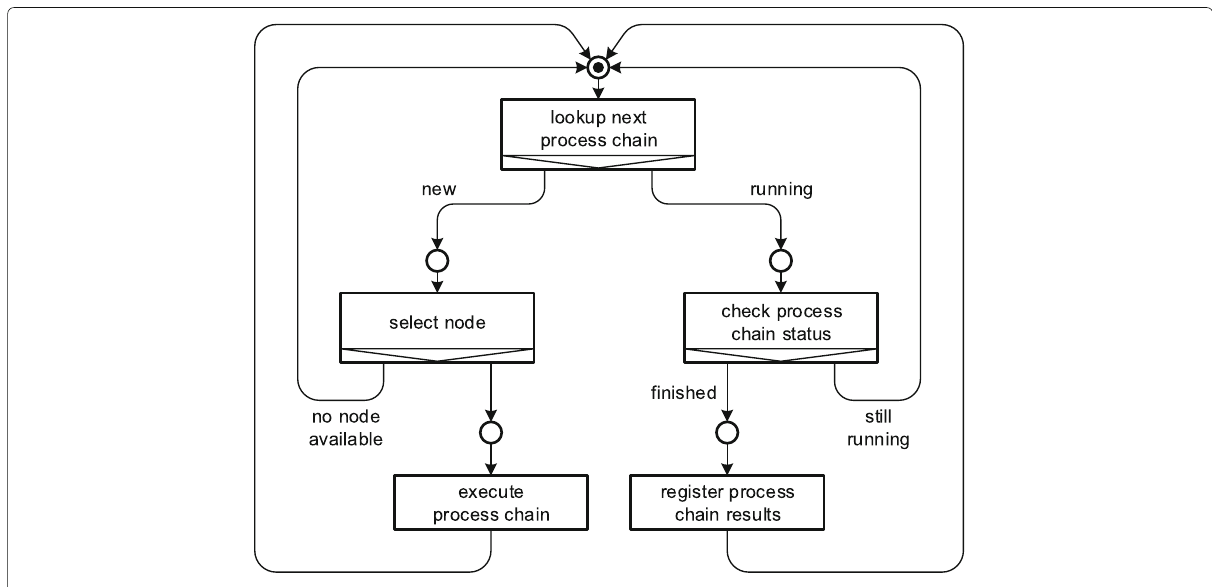
Fig. 13 The main control flow in the scheduler